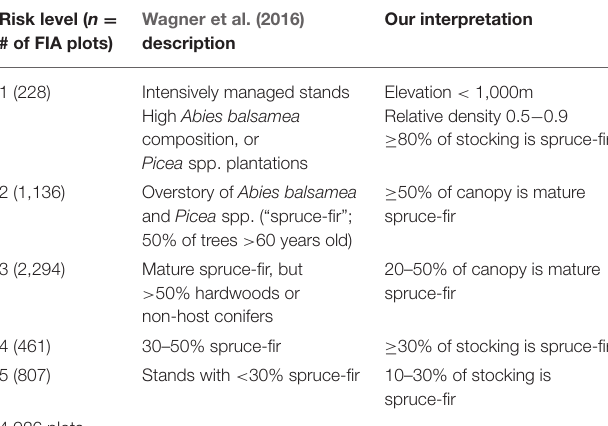
TABLE 2 | Spruce budworm risk categorization of US Forest Service Forest Inventory and Analysis (FIA) plots.